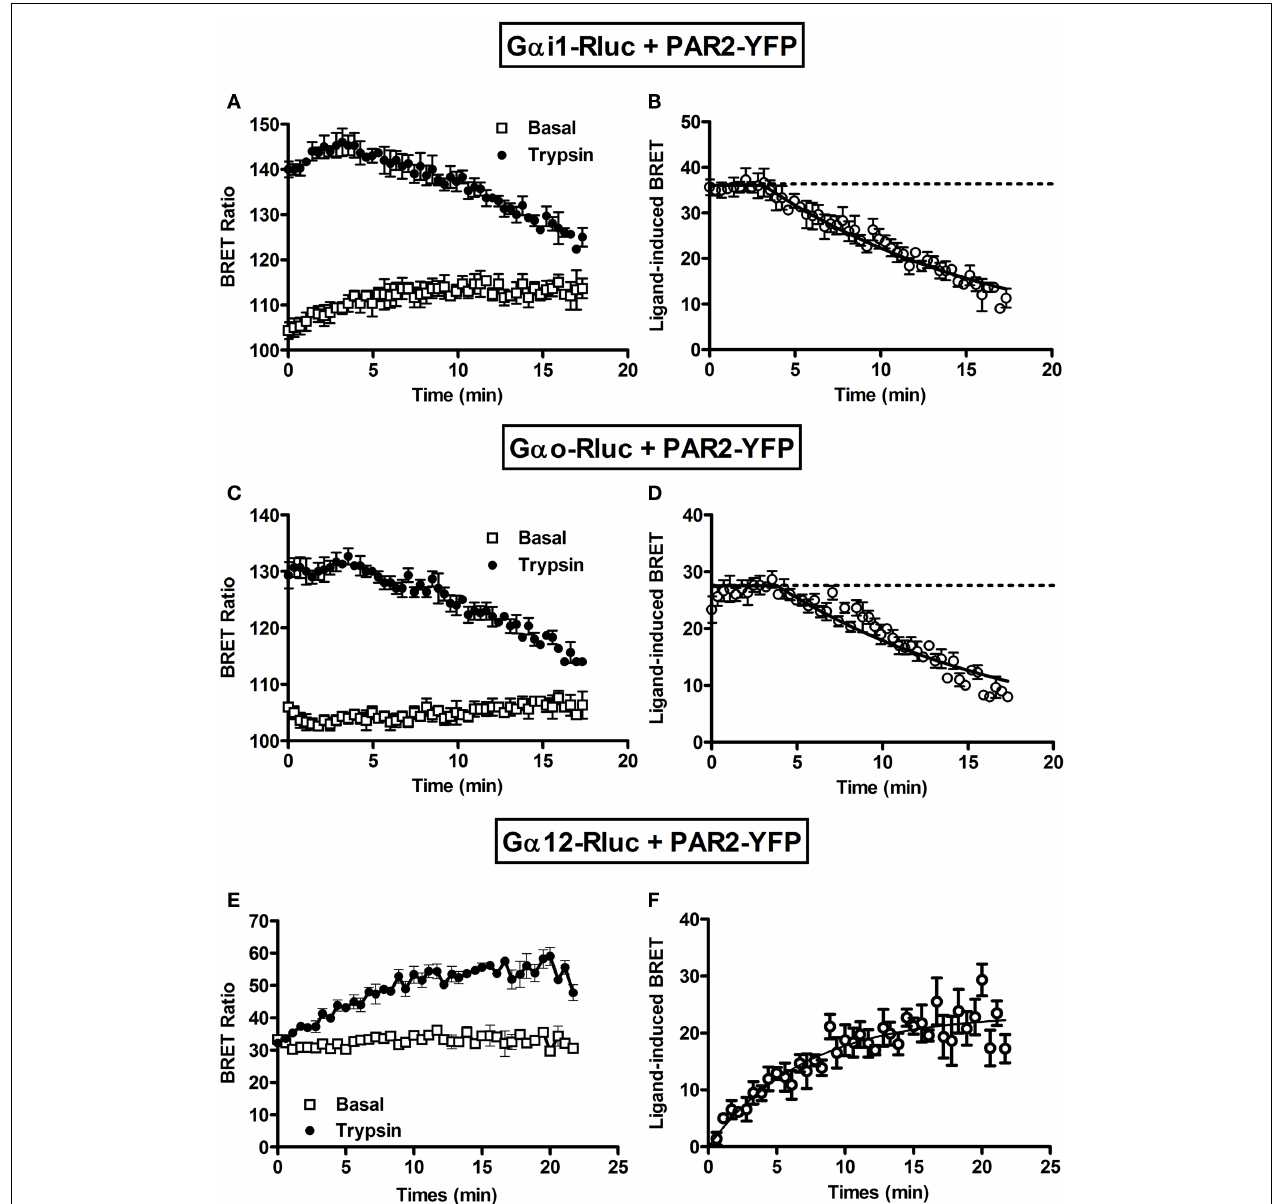
FIGURE 3 | Long-term kinetic analysis of trypsin-induced BRET increase (B,D,F) represent the Prism GraphPad fits of trypsin-induced BRET increase using either “Plateau followed by one phase decay” equation ( Y = IF[ X < X 0, between PAR2 and G α proteins . COS-7 cells transiently co-expressing PAR2-YFP and either G α i1-Rluc (A,B) or G α o-Rluc (C,D) or G α 12-Rluc Y 0, Plateau + ( Y 0 − Plateau)*exp( − K *( X − X 0))]) constraining the plateau to a theoretical value of 0 for G α i1 and G α o or “One phase exponential (E,F) were used for BRET experiments in the absence ( (cid:3) ) or presence of • 100nM of trypsin ( ). For this, repetitive signals were recorded every ~35s association” equation ( Y = Y max *(1 − exp( − K * X )) for G α 12. Data are immediately after trypsin addition during 18–20min.The panels mean ± SEM of three independent experiments performed in single